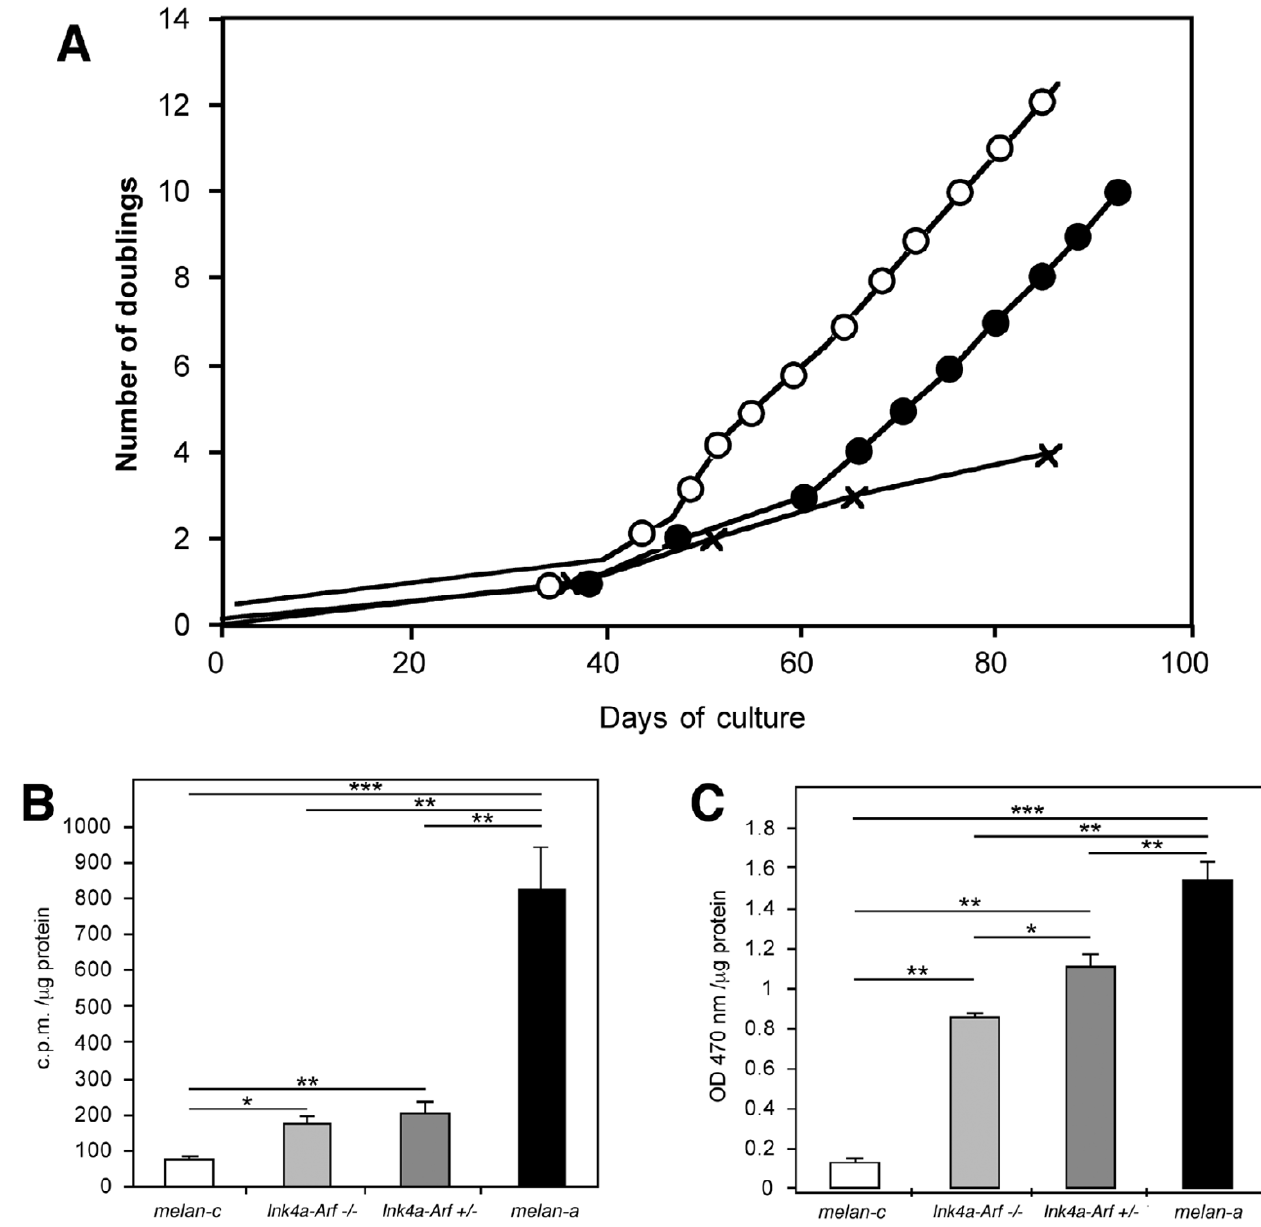
Figure 4 The effect of Ink4a-Arf locus on cell growth and Tyr enzymatic activity. (A) Cell growth of Ink4a-Arf -/- (open circles), Ink4a-Arf +/- (closed circles) and Ink4a-Arf +/+ (crosses) melanocytes. Each point represents one subculture step and represents the mean count of cells from three replicates. (B) Tyrosine hydroxylase activity in albino melan-c (white bars), [ Ink4a-Arf +/- ; Tyrp1 B / Tyrp1 B ] (dark-grey bars), [ Ink4a-Arf -/- ; Tyrp1 B / Tyrp1 B ] (light-grey bars) and melan-a (black bars) cells. (C) Melanin content in the same cellular types, as in (B). Bars represent the mean value (+/- SD) from three replicates. Tyrosinase activity and melanin content were measured in melanocyte primary cultures at passage 8 (~day 70 of culture). Statistically significant differences ( t -Student test) are indicated as follows: * p < 0,1; ** p < 0,01; *** p <